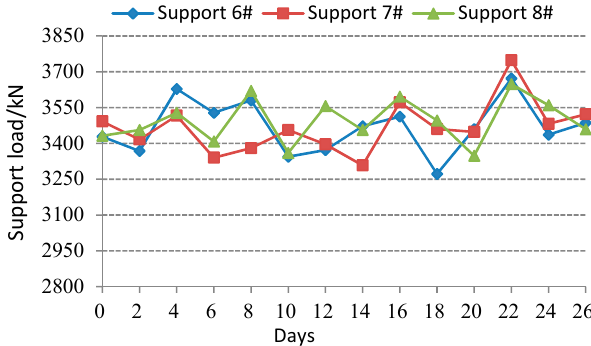
Figure 8. Behavior of the support load in the lower area of the working face.